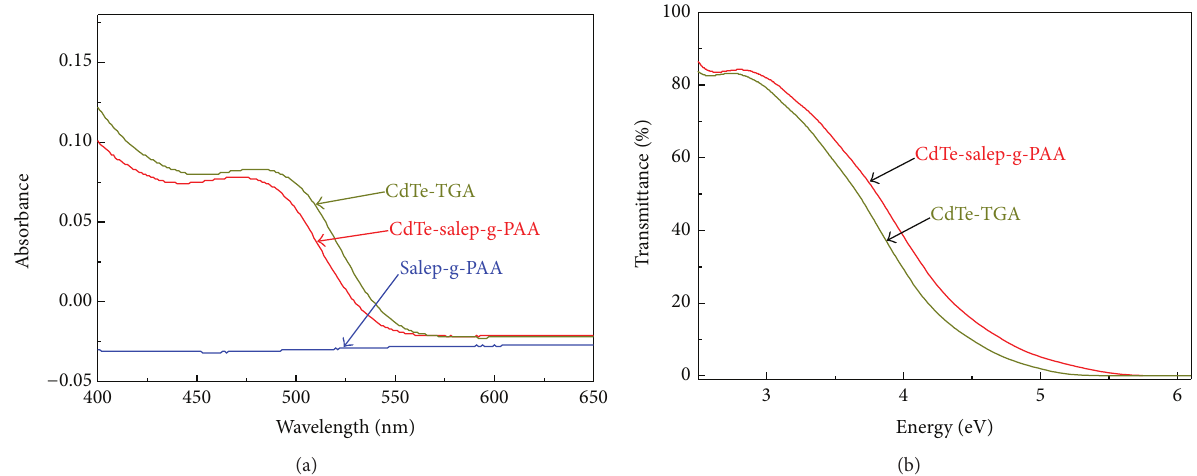
Figure 1: (a) UV-vis absorption and (b) transmittance spectrum of salep-g-PAA, CdTe-TGA, and CdTe-salep-g-PAA QDs.